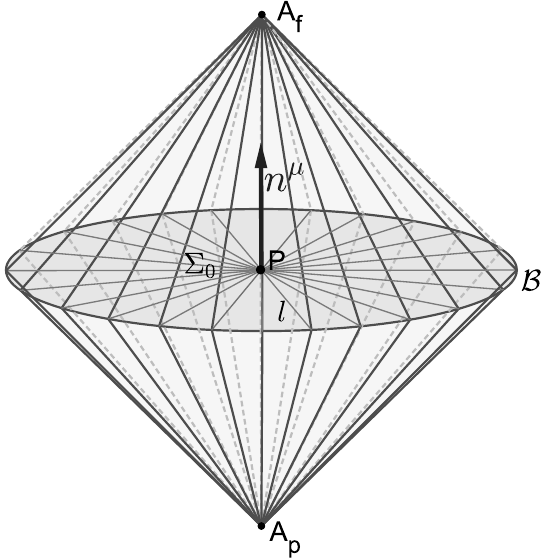
Figure 1. A representation of a GLCD having originated from point P (where the angular coordinate is suppressed) and with a unit time-like vector n µ . The geodesics of length l form the spatial geodesic ball Σ 0 , whose boundary B is an approximate 2-sphere . The boundary of the diamond given by the null geodesic generators runs from the past apex A p ( t = − l / c ) to the future apex A f ( t = l / c